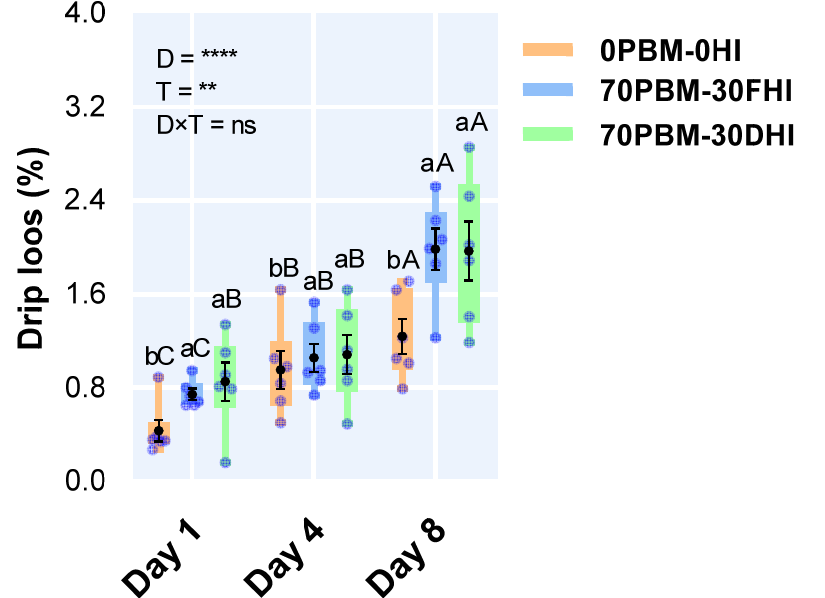
Figure 2. Changes in drip loss after the 8-weeks feedin trial and at day 1, day 4, and day 8 when stored at 4 °C in barramundi fed complete replacement of fishmeal (FM) diets with a mixture of poultry by-product meal (PBM), full-fat Hermetia illucens (FHI), and partially defatted Hermetia illucens (DHI) larvae meal. Semi-transparent light blue round markers indicate individual datapoints ( n = 6), while the box–whisker plot of individual datapoints and black markers denote the mean and standard error values, respectively. Lower case letters indicate significant differences between the treatments, while upper cases in the figure indicate significant differences between the storage days. Asterisks represent the significant differences at ** p < 0.01, and **** p < 0.001; ns denotes non-significant.